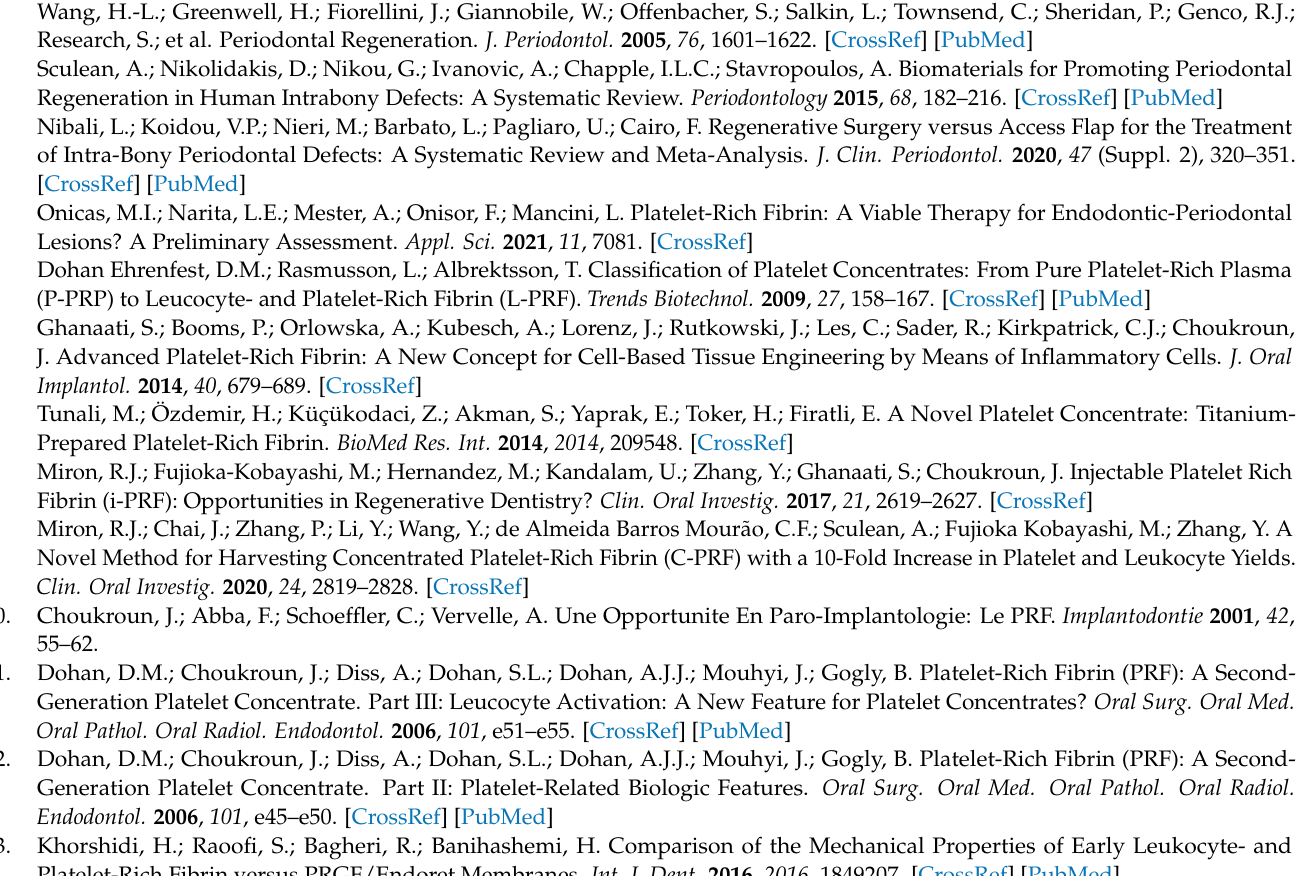
Forest plot of comparison: 2 Endosseous Defects, outcome: 2.1. Clinical Attachment Level Gain, Figure S3: Forest plot of comparison: 3 Endosseous Defects, outcome: 3.1. Defect Depth Reduction, Figure S4: Forest plot of comparison: 4 Furcation Defects, outcome: 4.1. Probing Pocket Depth Reduc- tion, Figure S5: Forest plot of comparison: 5 Furcation Defects, outcome: 5.1. Clinical Attachment Level Gain, Figure S6: Forest plot of comparison: 6 Furcation Defects, outcome: 6.1. Defect Depth